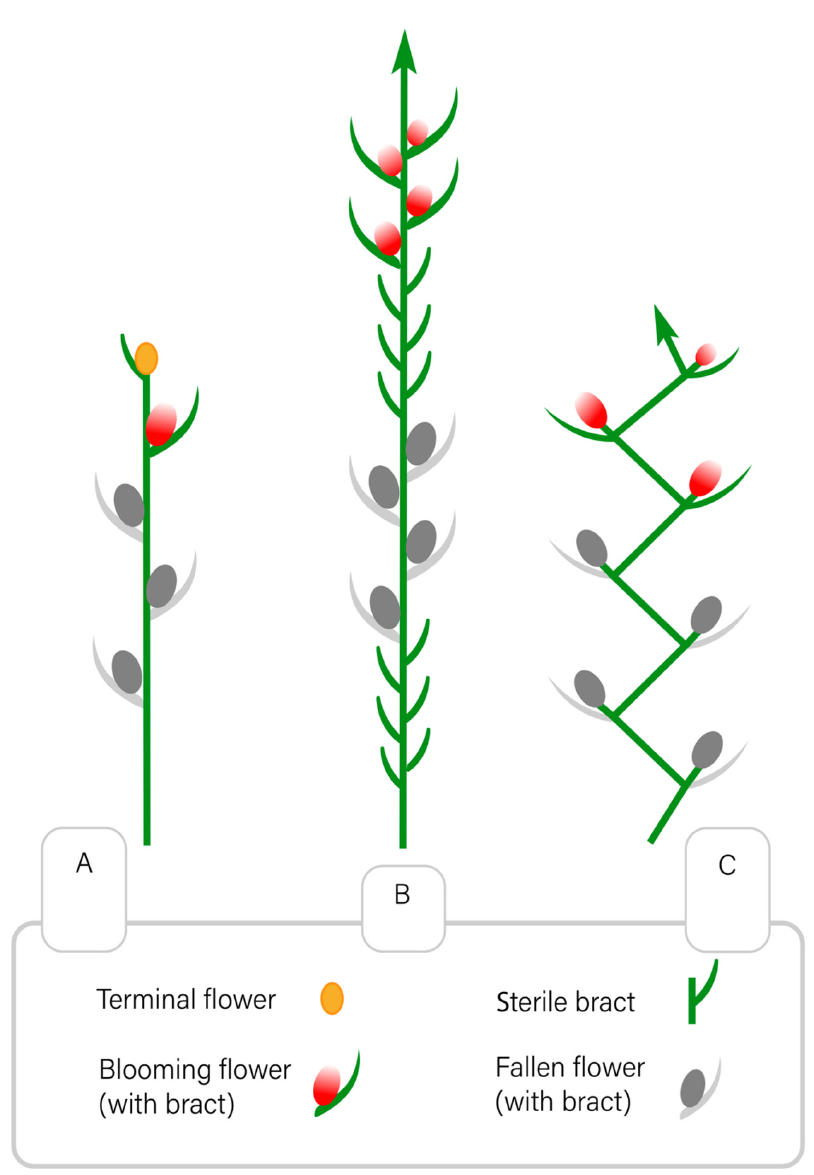
Figure 6. Schematic views of inflorescences: ( A ) C. ovalis : determinate bracteous spike (stachyoid); ( B ) C. prolifera : indeterminate bracteous spike (intercalary inflorescence); ( C ) C. monilirachis : compound monochasial cyme.